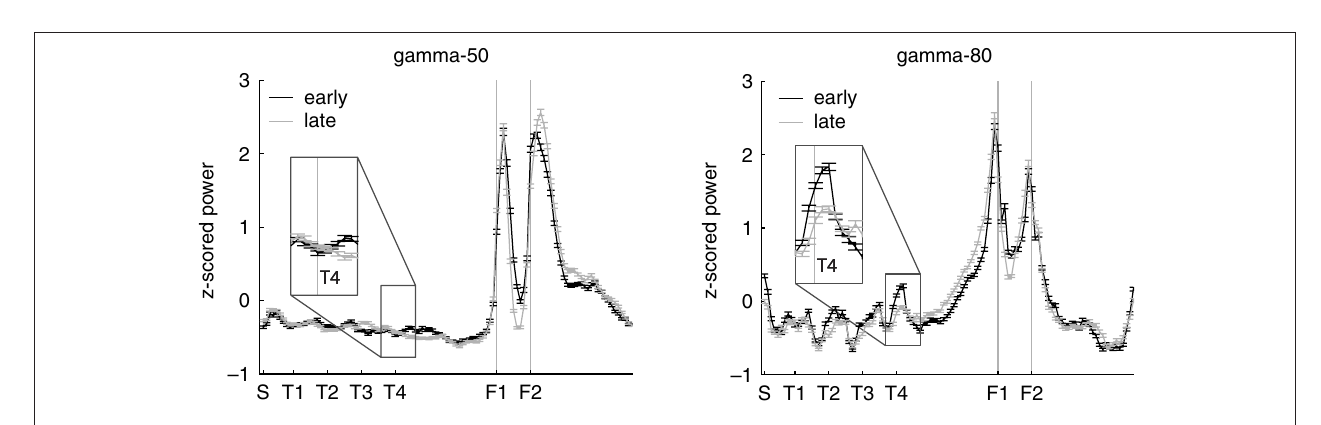
FIGURE 8 | Gamma-80, but not gamma-50, power was elevated at the fi nal choice point (T4) during early laps. Shown are average z -scored power values for the fi rst quarter of recording sessions (fi rst 10 min, black) and the last quarter (fi nal 10 min, grey) for gamma-50 (left) and gamma-80 (right).